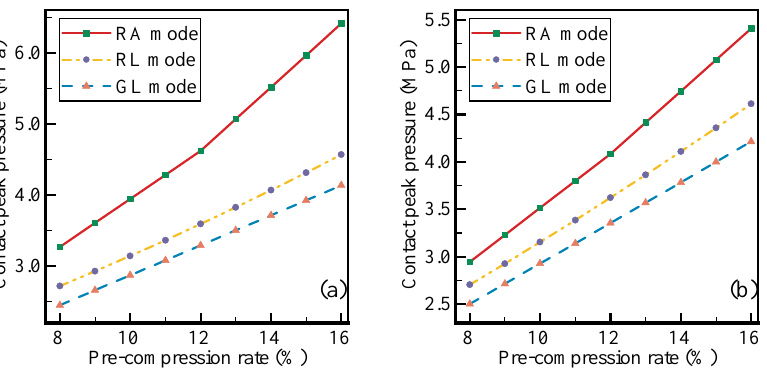
Figure 7. Comparison of installation mode on contact peak pressure. The contact peak pressure of the three installation modes are shown in ( a ) for piston rod side and in ( b ) for groove side, respectively.